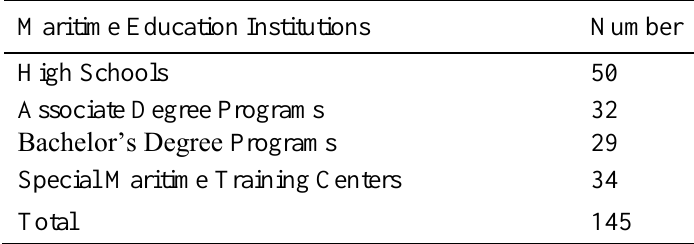
Table 1. Maritime education and training institutions in